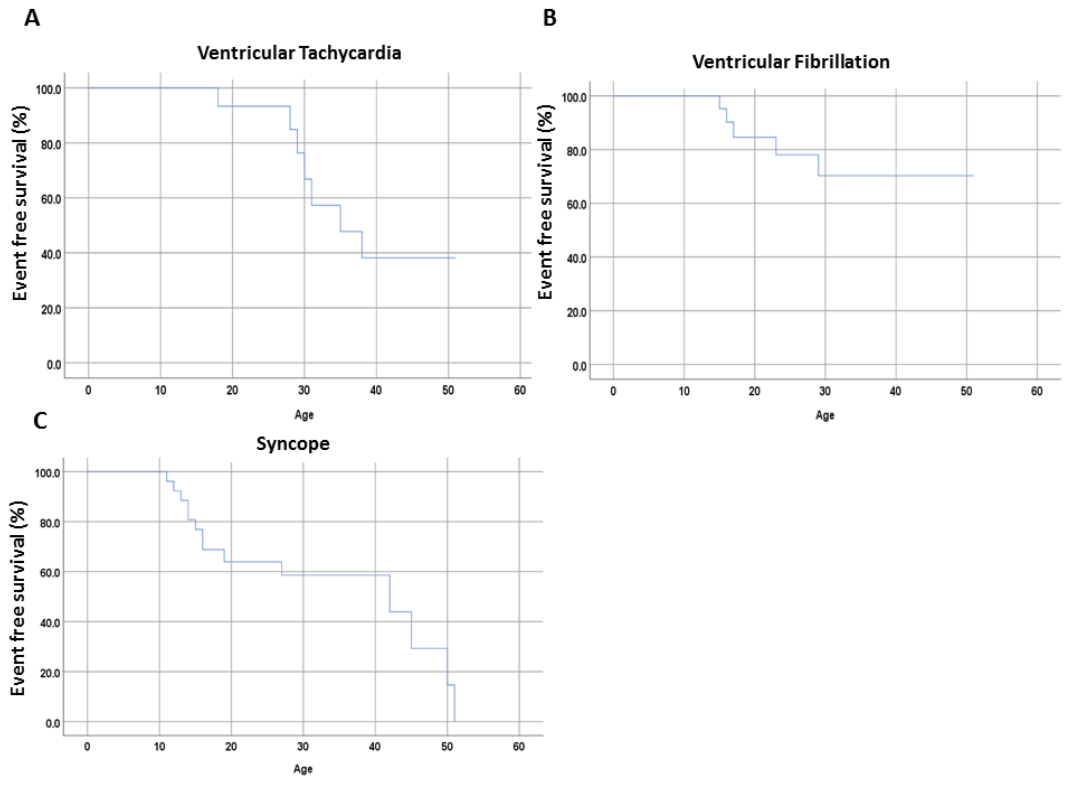
Figure 6. Kaplan-Meier curvesillustrate the proportion of cardiac event free timein the families with CPVTof the present study. ( A ) Ventricular Tachycardia; ( B ) Ventricular Fibrillation; ( C )